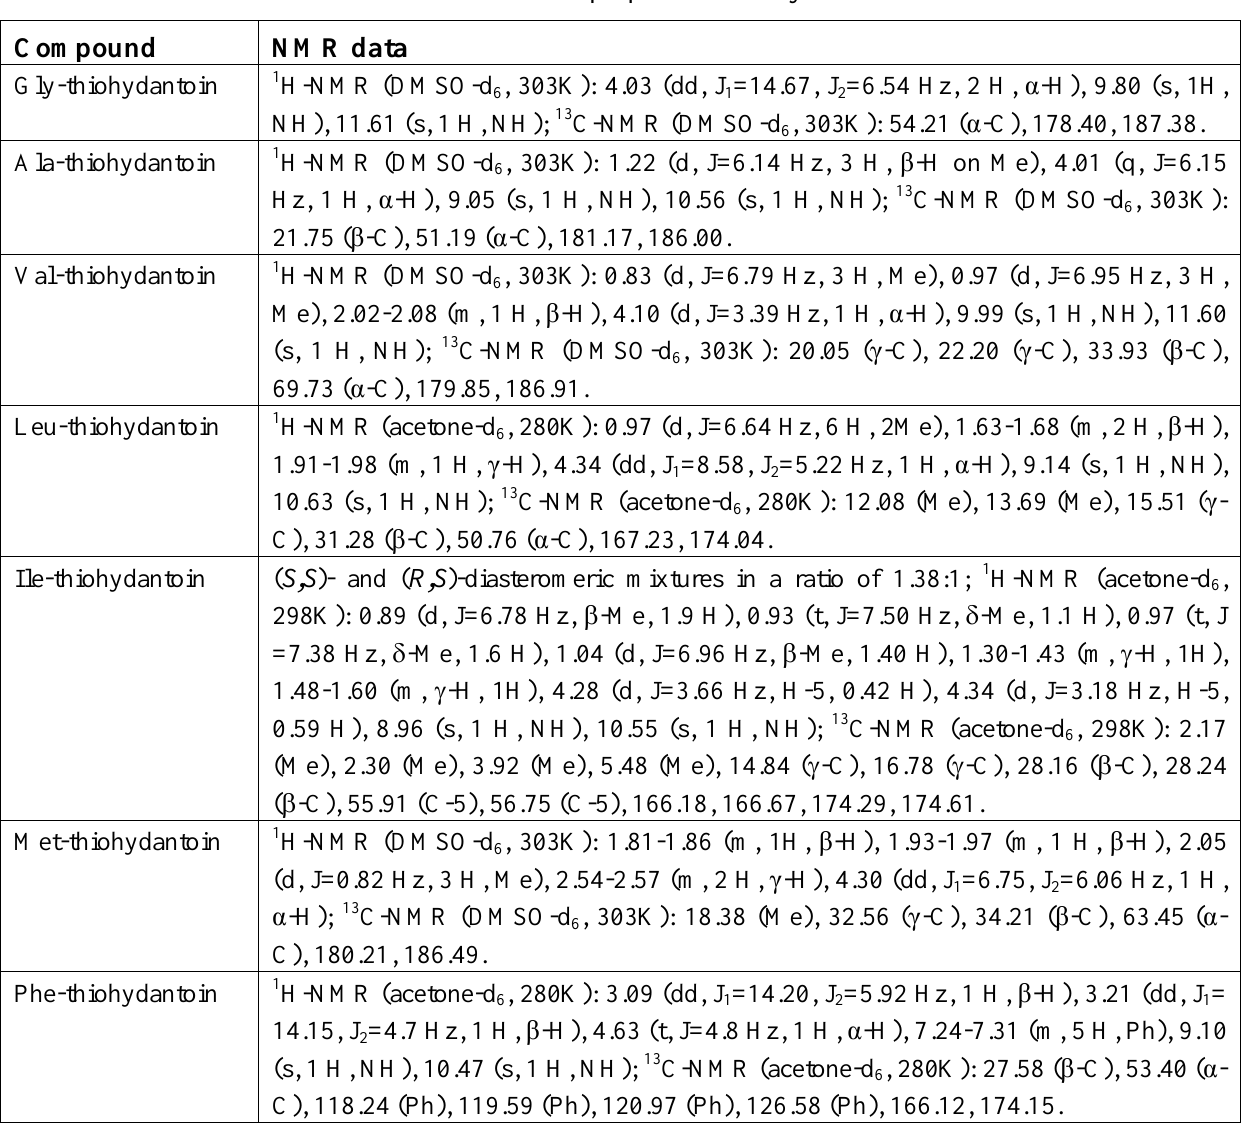
Table 3. NMR data of prepared